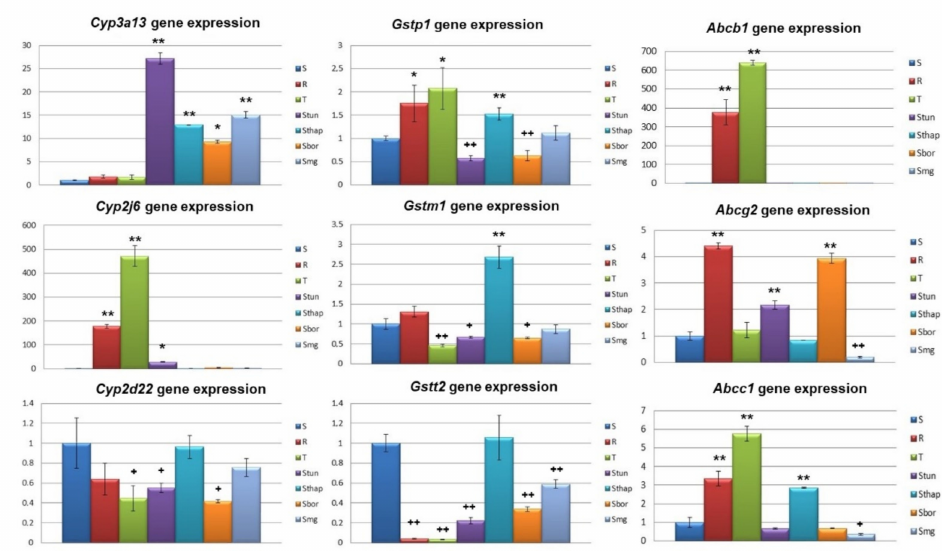
Figure 3. qRT-PCR quantification of Cyp ( Cyp3a13 , Cyp2j6 and Cyp2d22 ), Gst ( Gstp1 , Gstm1 and Gstt2 ) and Abc ( Abcb1 , Abcg2 and Abcc1 ) gene expression (using the primers listed in Table 2 in S, R, T, S Tun , S Thap , S Bor and S MG-132 cells. Transcript levels were normalized to the β -actin housekeeping gene and are expressed as the mean ± S D of three independent measurements. Significance: Data are higher than those in S cells at * p < 0.02, ** p < 0.005; Data are lower than those in S at + p < 0.05, ++ p <